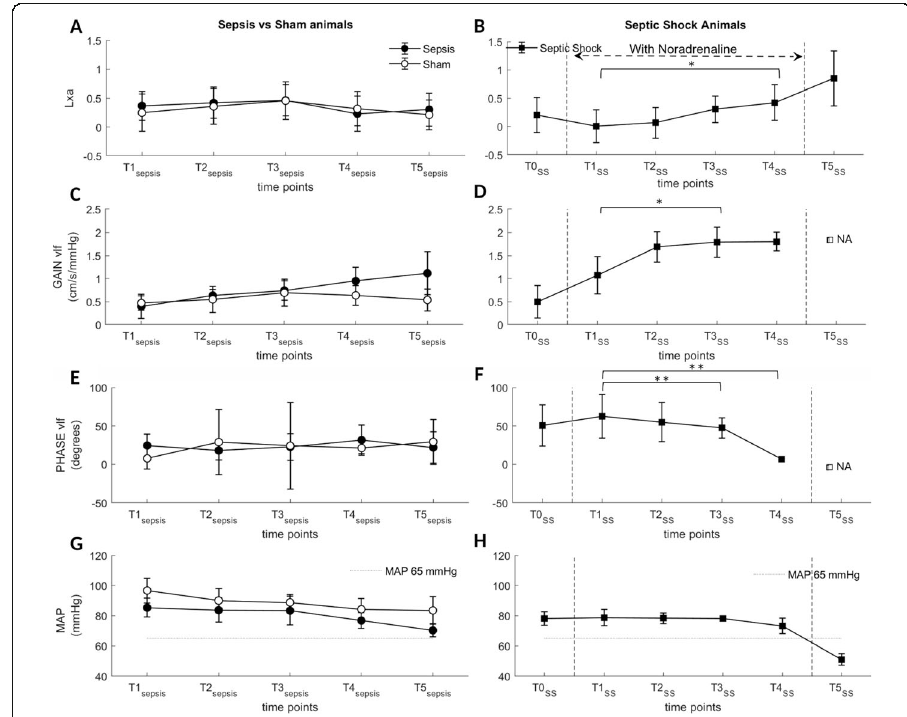
Fig. 2 Temporal evolution of dynamic cerebral autoregulation parameters during experimental sepsis. Lxa ( a , b ), TFA gain ( c , d ), and phase ( e , f ), and of mean arterial pressure ( g , h ) in sepsis vs. sham ( a , c , e , g ) and septic shock ( b , d , f , h ). No difference was observed between the sepsis and sham groups but a progressive increase in Lxa, TFA gain, and a progressive decrease in TFA phase was observed in the septic shock group, indicating progressive loss of dCA. N/A = not available data, due to coherence values below significance (see the “ Materials and Methods ” section). Data are presented as median ± mean absolute deviation. * p < 0.05; ** p <